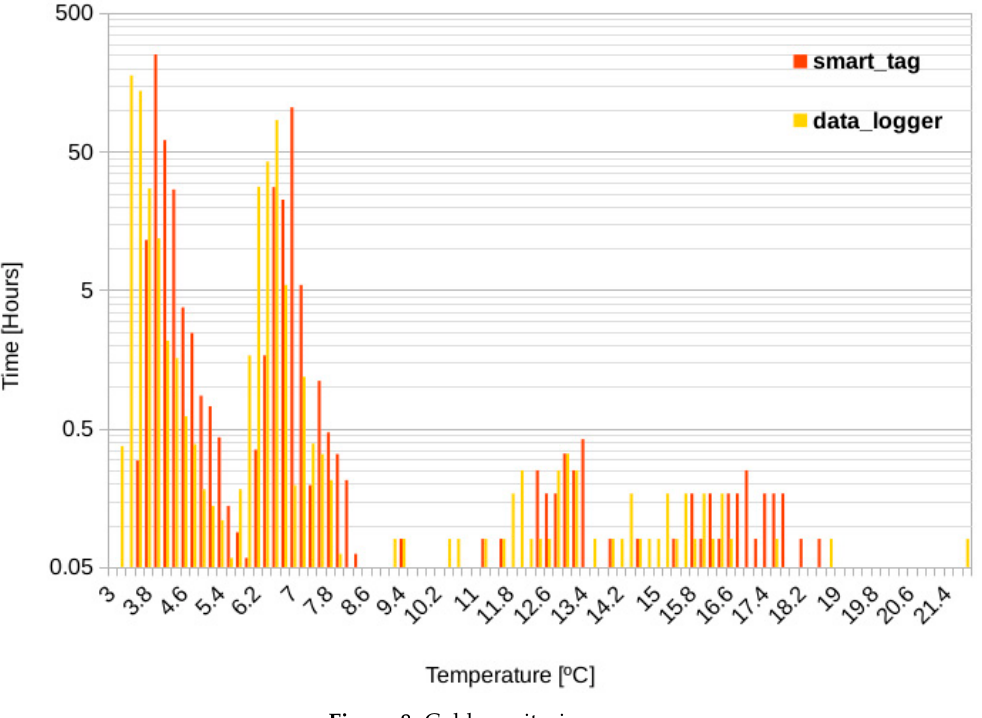
Figure 8. Cold monitoring case.